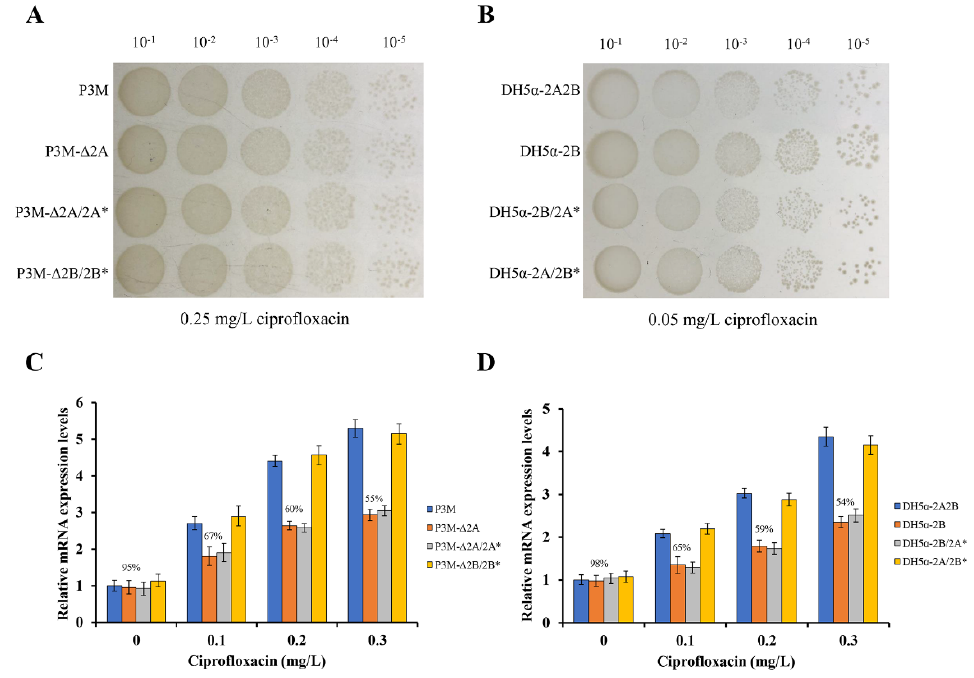
Figure 2. ( A ) Spot growth assays of wild-type (WT) P3M, p3M-2A deleted strain (P3M- ∆ 2A), p3M-2A* complemented strain (P3M- ∆ 2A/2A*), and p3M-2B* complemented strain (P3M- ∆ 2B/2B*) on LB agar in the presence of 0.25 mg/L of ciprofloxacin. ( B ) Spot growth assays of DH5 α transformant containing both plasmids (DH5 α -2A2B), DH5 α transformant containing p3M-2B (DH5 α -2B), DH5 α -2B strain complemented with p3M-2A* (DH5 α -2B/2A*), and DH5 α -2A strain complemented with p3M-2B* (DH5 α -2A/2B*) on LB agar in the presence of 0.05 mg/L of ciprofloxacin. ( C ) Expression of qnrD in P3M, P3M- ∆ 2A, P3M- ∆ 2A/2A*, and P3M- ∆ 2B/2B* with different ciprofloxacin concentrations. ( D ) Expression of qnrD in DH5 α -2A2B, DH5 α -2B, DH5 α -2B/2A*, and DH5 α -2A/2B* with different ciprofloxacin concentrations.